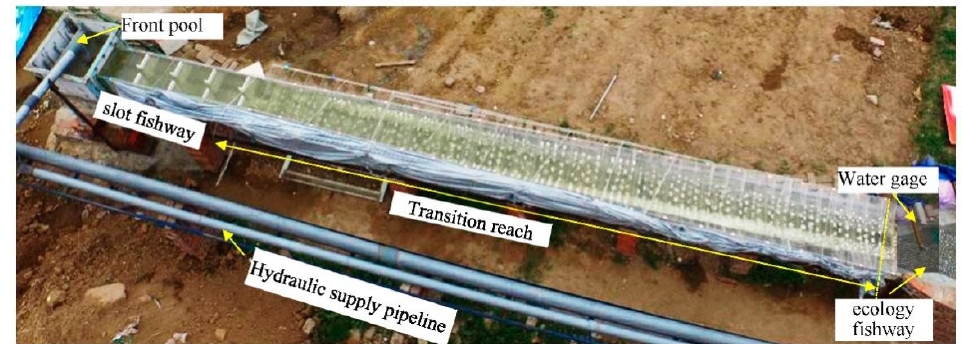
Figure 19. Aerial view of the fishway model with the DWO and experimental system. The geometric scale of the model was 10. The model is 16 m long and made up of polymethyl methacrylate, which can satisfy the resistance similarity and is transparent in all directions. The pipeline is used to supply the circulating hydrodynamics, and the discharge is controlled by an E-mag flow meter. The water level of the outlet is measured by a water gauge, while the velocity is measured by an ADV and propeller current meter in shallow water.